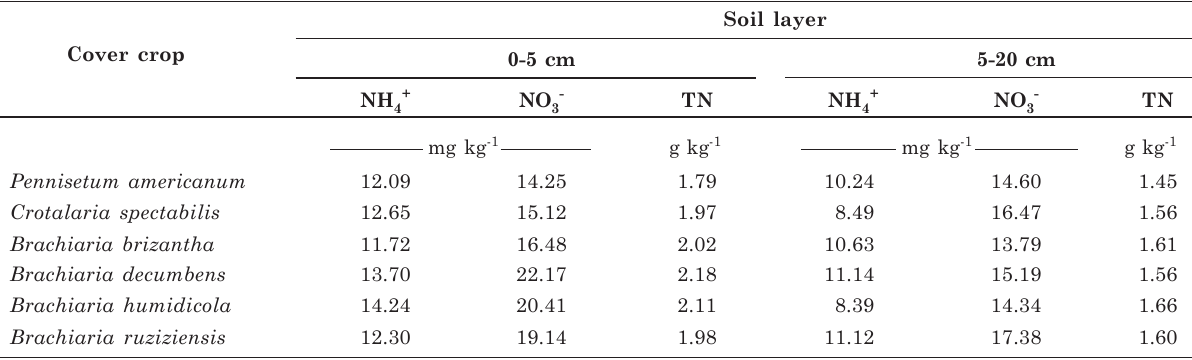
Table 2. Ammonium (NH 4+ ), nitrate (NO 3- ), and total nitrogen (TN) concentration in the two soil layers as affected by cover crops, evaluated immediately before upland rice sowing